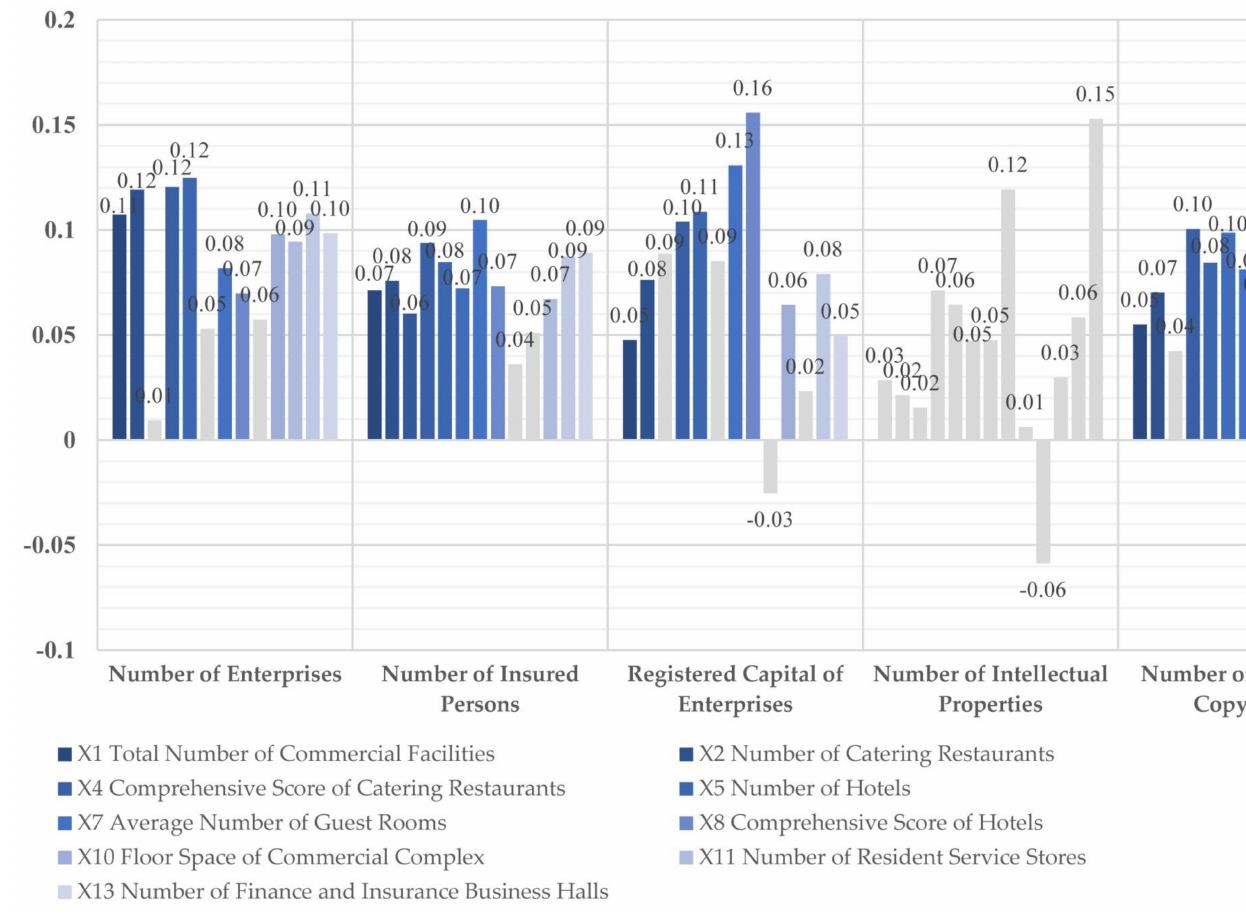
Figure 11. Standardized regression coefficients (The gray bar charts indicate that independent variables and dependent variables are not significantly